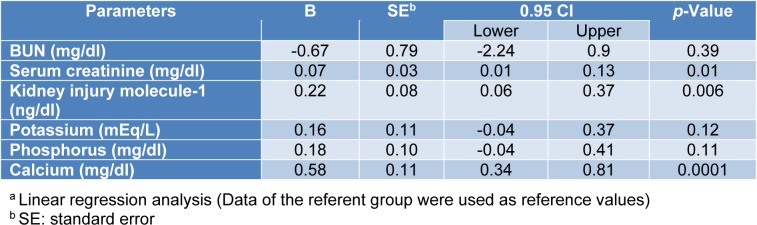
Association between urinary levels of the WAGs and the parameters of kidney function testsa